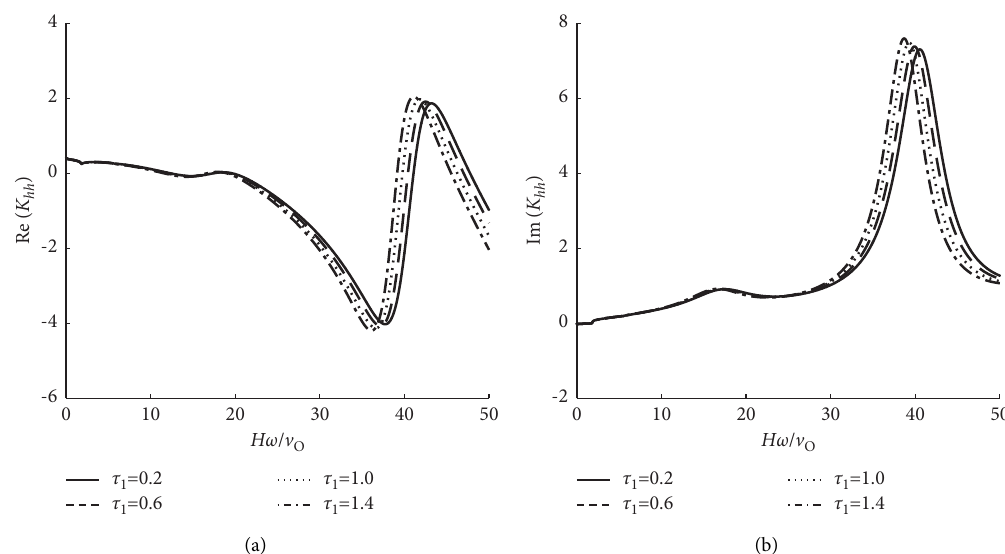
Figure 15: The horizontal dynamic impedance curves of pipe pile under different model parameter ratios ( τ horizontal dynamic impedance. (b) Imaginary part of horizontal dynamic impedance.